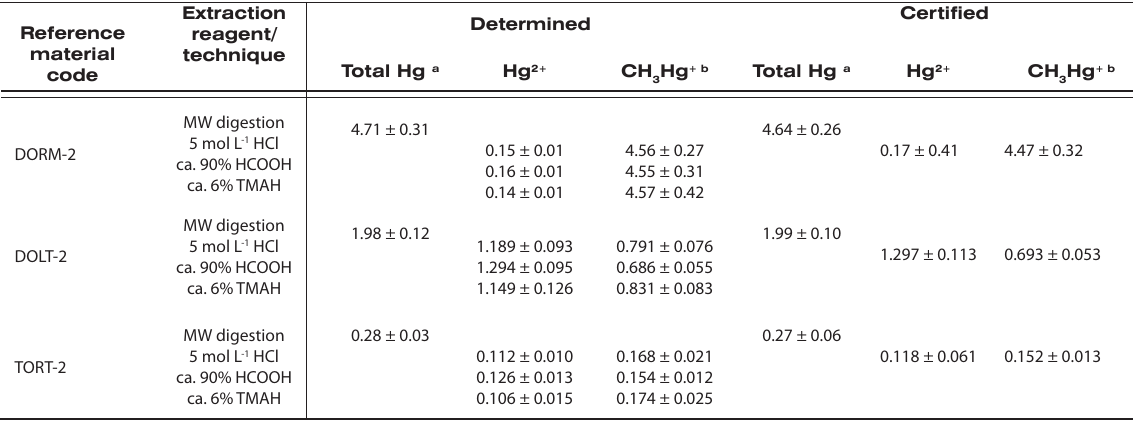
Table 4. Validation of methods for total, inorganic and methylmercury in selected ertified reference biological materials by CVAAS using the